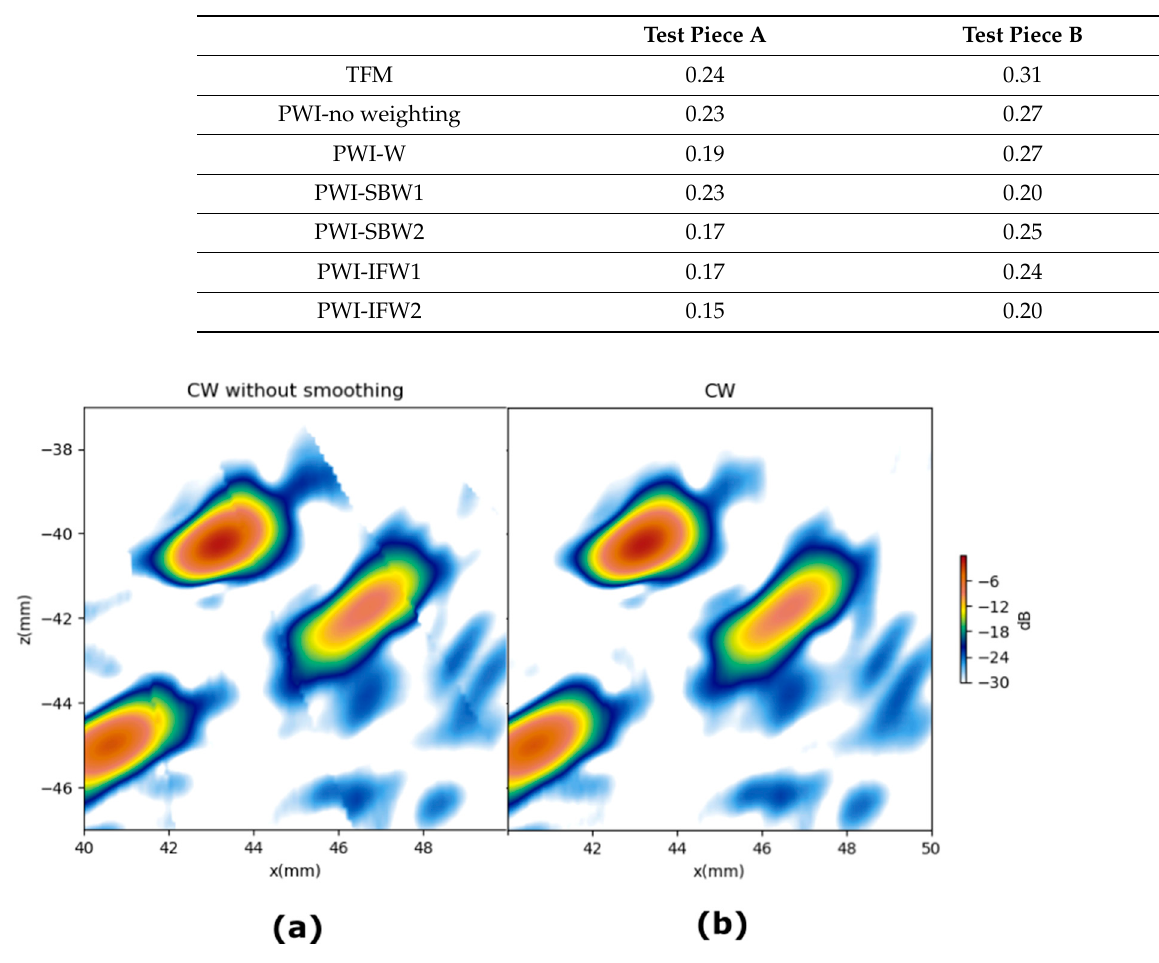
Figure 14. Fringing artifact. ( a ) Discontinuous weighting mask. ( b ) Smoothed weighting mask.